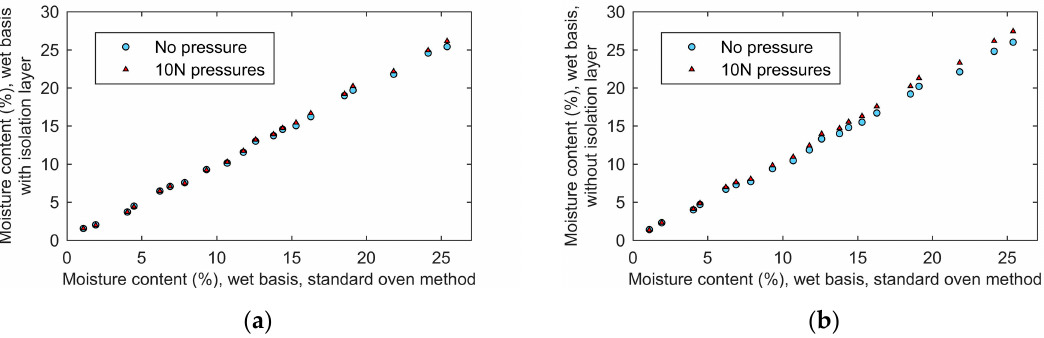
Figure 24. The influence of pressures on the measurement: ( a ), with the isolation layer; ( b ), without the isolation layer.